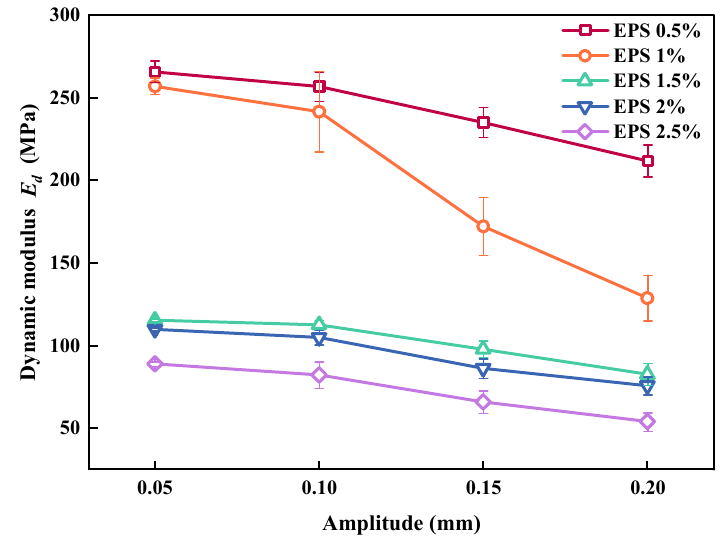
Figure 12. Relationship between amplitude and E d .